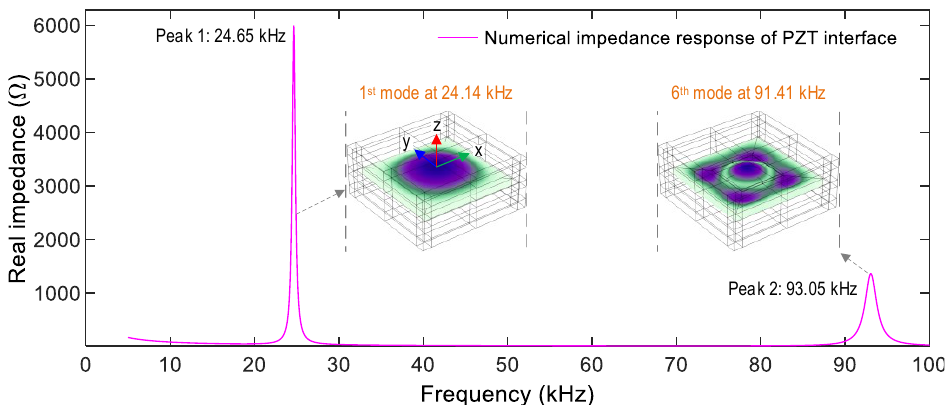
Figure 6. Numerical impedance responses of the PZT interface.